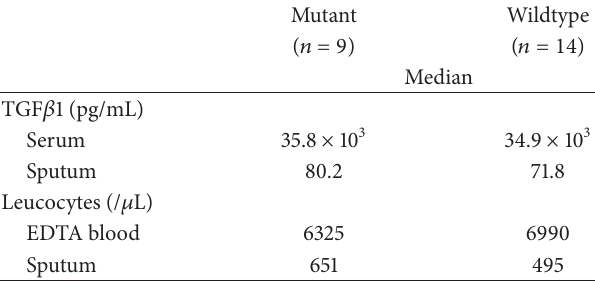
Table 7: TGF 𝛽 1 variant +869T- > C. TGF 𝛽 1 and